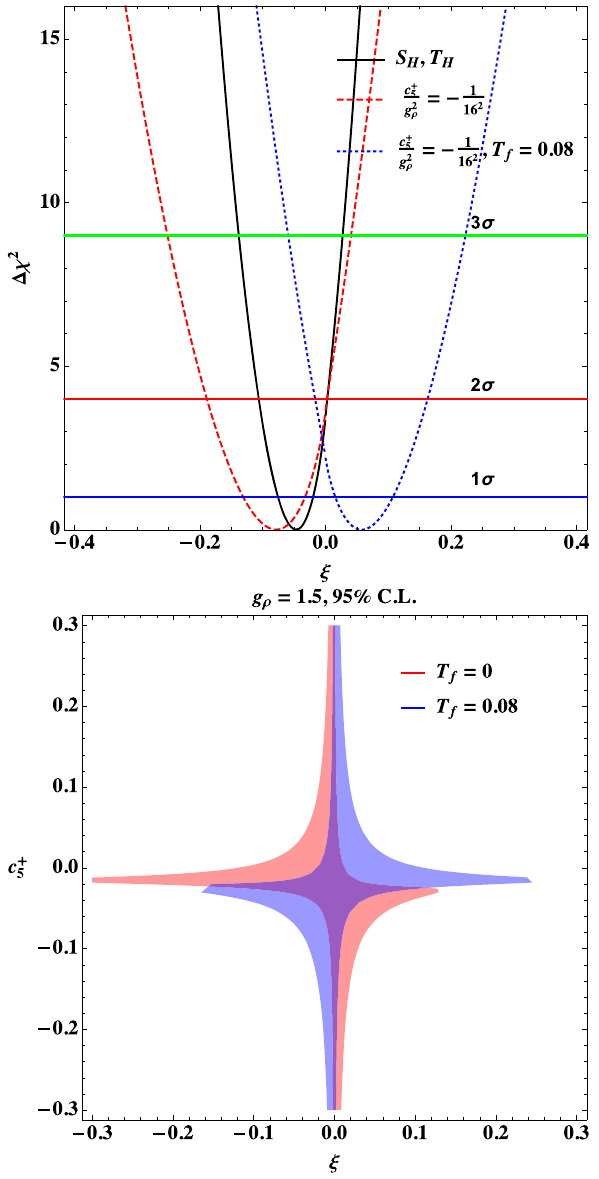
Fig. 8 Bounds from S , T parameters. Left plot: Δχ 2 as a function of ξ under different assumptions in Eq. (1). Right plot: 95% C.L. allowed plane with g ρ = 1 . region in the ξ − c + 5